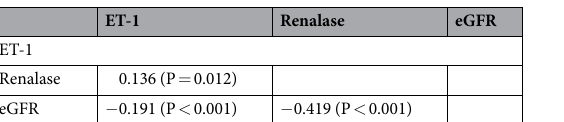
vs. 1.63 ± 0.65 pg/ml, P < 0.001), and were higher in patients using diuretics than in those not using diuretics (1.92 ± 1.08 vs. 1.65 ± 0.68 pg/ml, P = 0.013, Table 2). Synergistic effect of renalase and CKD on serum ET-1 levels. As shown in Table 3, serum ET-1 levels were positively correlated with serum renalase levels ( r = 0.136, P = 0.012) and inversely correlated with the eGFR